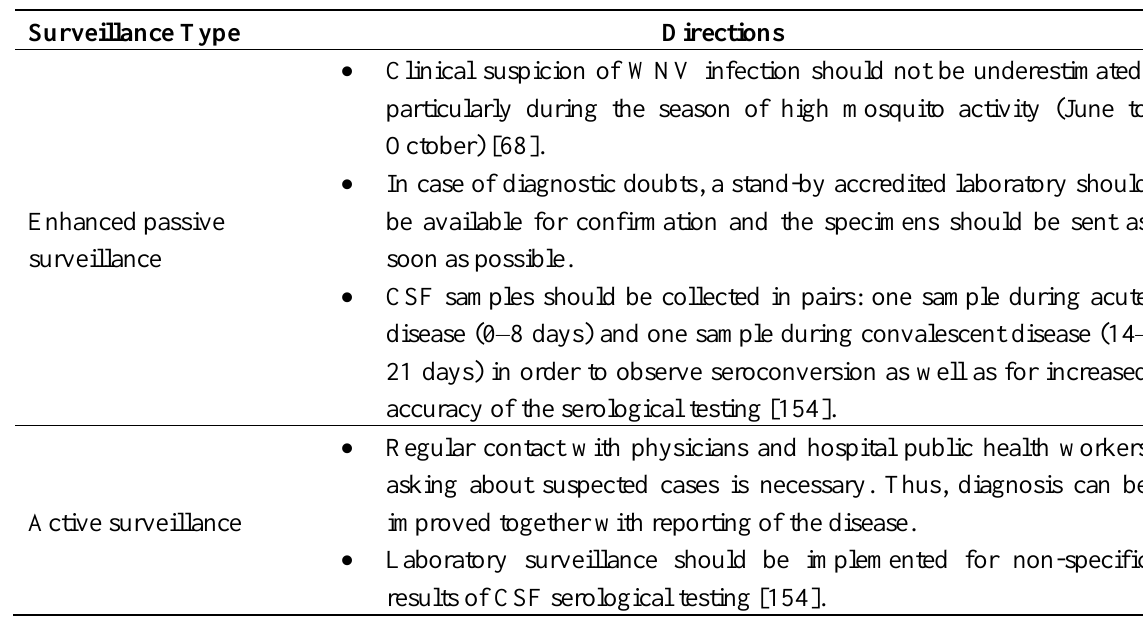
Table 6. Types of WNV human